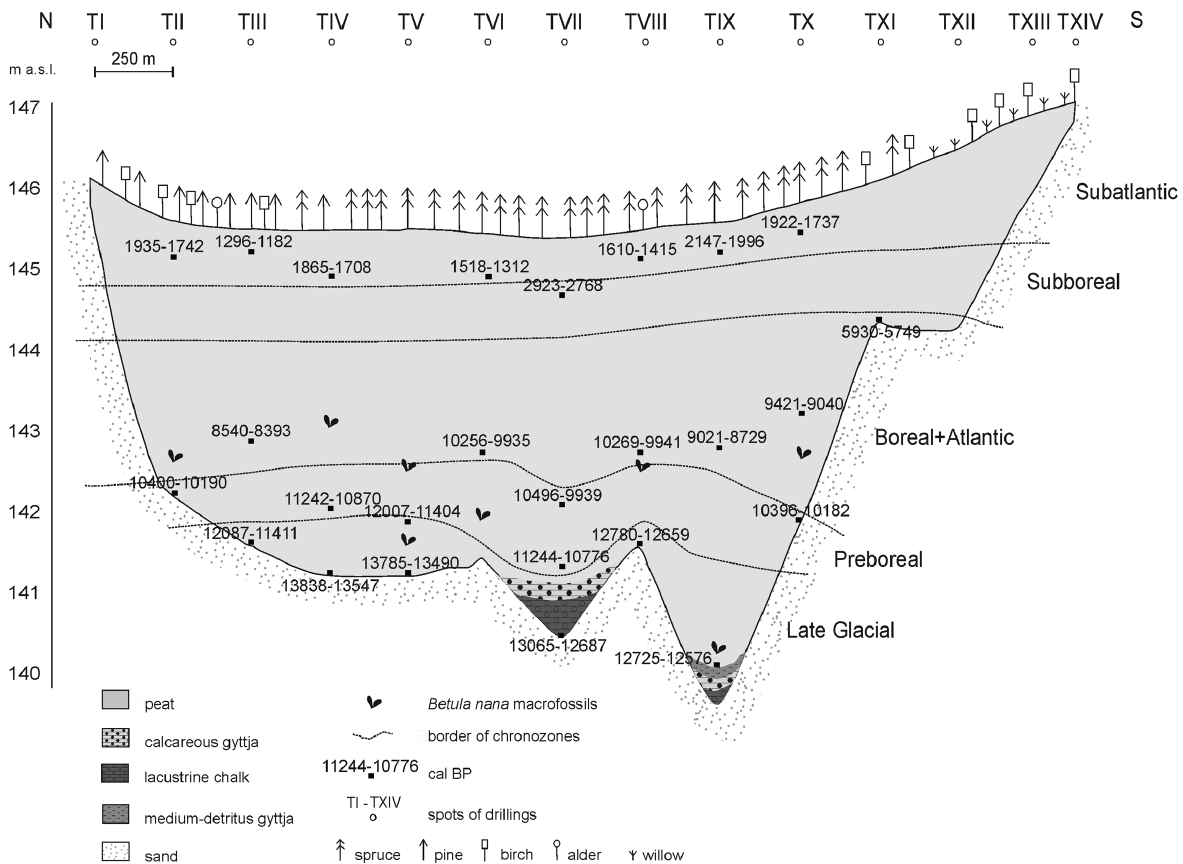
Fig. 4. Longitudinal cross section of the Tabo ł y mire